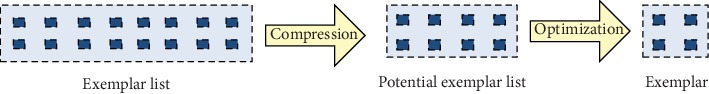
Framework of FEEC algorithm: compression stage and optimization stage.